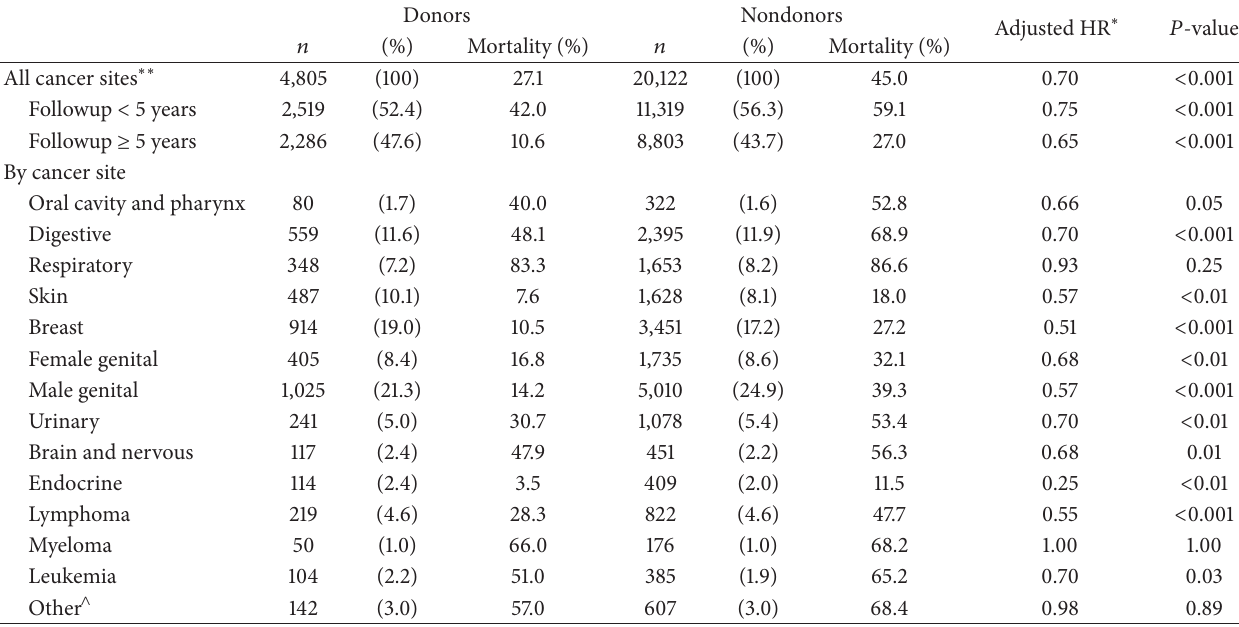
Table 4: Adjusted Cox proportional regression models for all-cause mortality, comparing donors and nondonors with cancer, by cancer site, Blood Centers of the Pacific and California Cancer Registry, 1991–2009 ( 𝑛 =